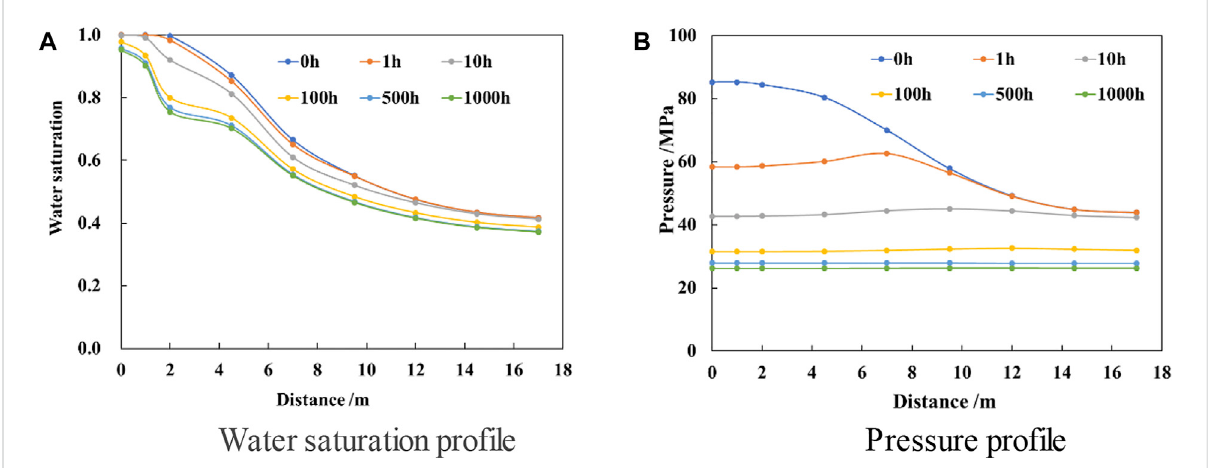
FIGURE 11 Change of water saturation and pressure of the fracture system at different times. (A) Water saturation pro fi le; (B) Pressure pro fi le.